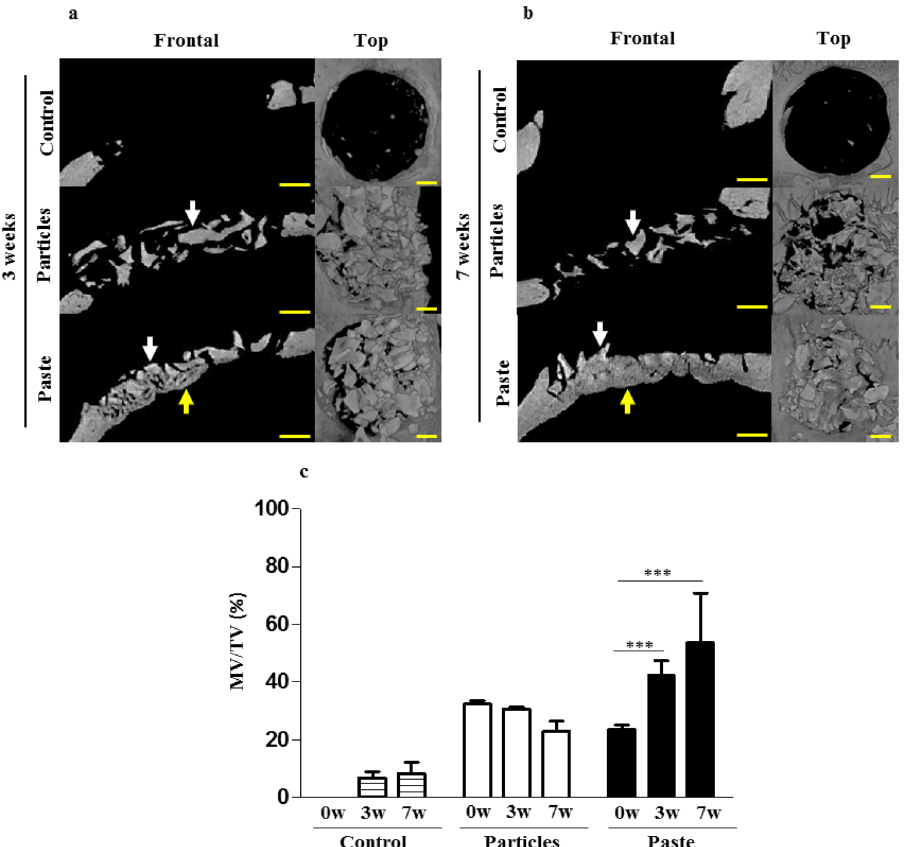
Figure 4. Rat calvaria healing at 3 and 7 weeks after surgery in a critical size defect model. ( a , b ) Representative images of the reconstructed µ-CT acquisitions (yellow arrows: newly formed bone, white arrows: grafts). The control represents the unfilled defects. Scale bars: 1 mm. ( c ) Three-dimensional µ-CT quantitative analysis of the mineral volume (MV) within the tissue volume (TV) in the defects after 0 weeks (baseline), 3, and 7 weeks of regeneration. The results are expressed as means ± the SD (n = 6) ** p < 0.01, *** p <